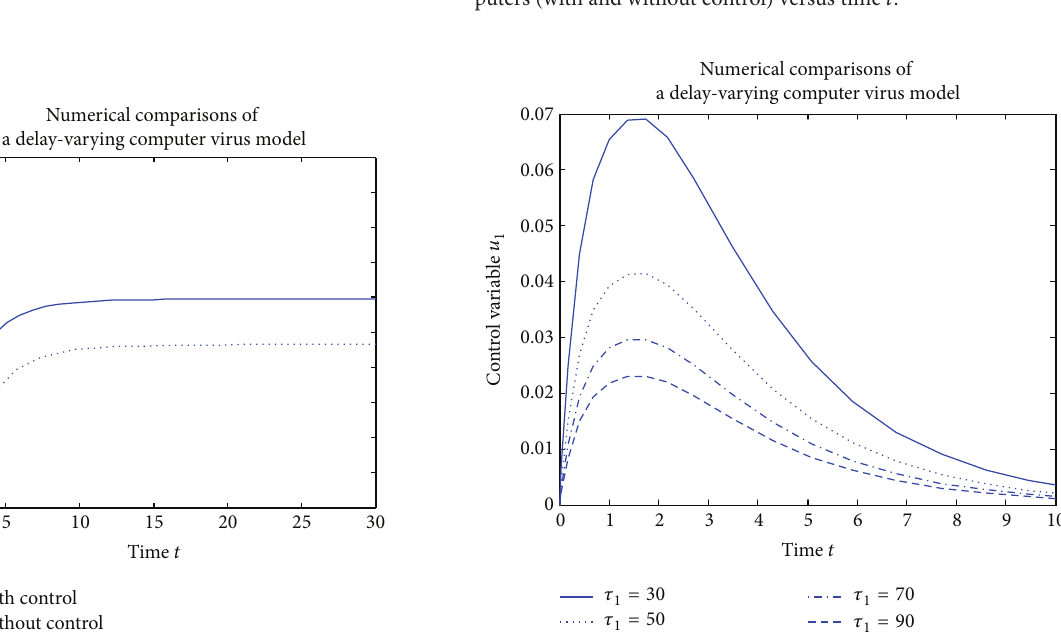
Figure4:Quarantinedcomputers(withandwithoutcontrol)versus time 𝑡 .